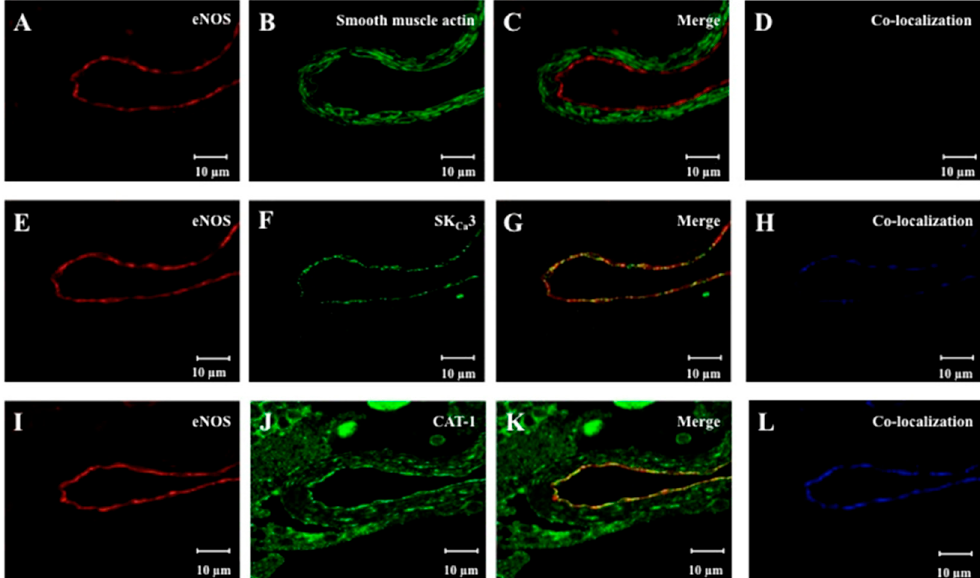
Figure 1. 3 H- l -arginine uptake in rat aortic valve endothelial cells in the absence and presence of the combination of apamin (0.5 µ M), a SKCa channel blocker, and charybdotoxin (ChTX, 0.1 µ M), an IKCa channel blocker, and of l -lysine (600 µ M), both inhibiting l -arginine uptake through the CAT system, and of low Na + -PSS which inhibits L-arginine uptake through the Na + -dependent (Bo, + ) CAT system. Data are means ± S.E.M. ( n = 6). One-way ANOVA. # p < 0.05 vs. baseline. * p < 0.05 vs. control.